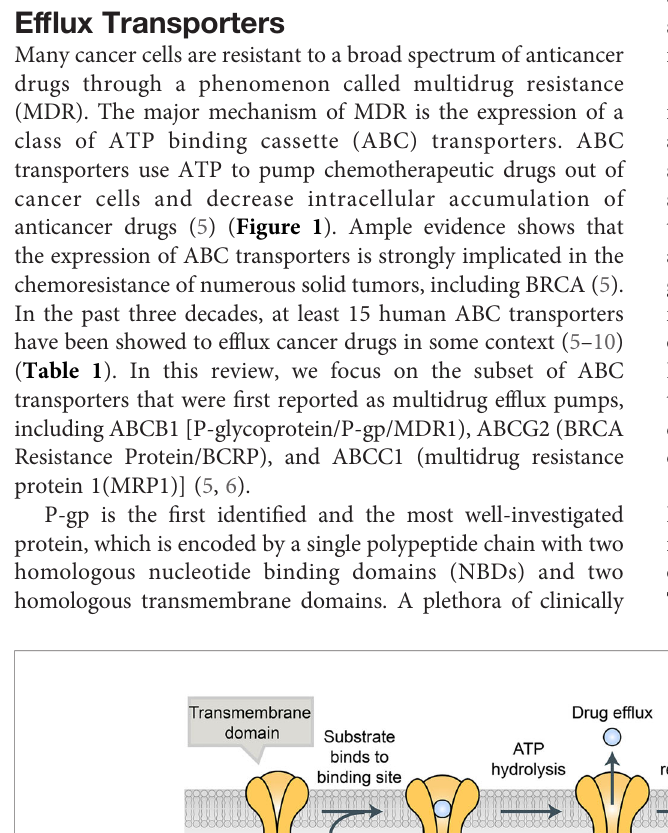
FIGURE 1 | The substrate binds to the binding pocket in TMDs and ATP binds to the two binding sites in the NBDs. This is followed by the hydrolysis of ATP that generates a conformational change, allowing the substrate to be released from the protein. The second molecule of ATP is hydrolyzed, allowing for a conformational reset, where substrate and ATP can bind again so the process can